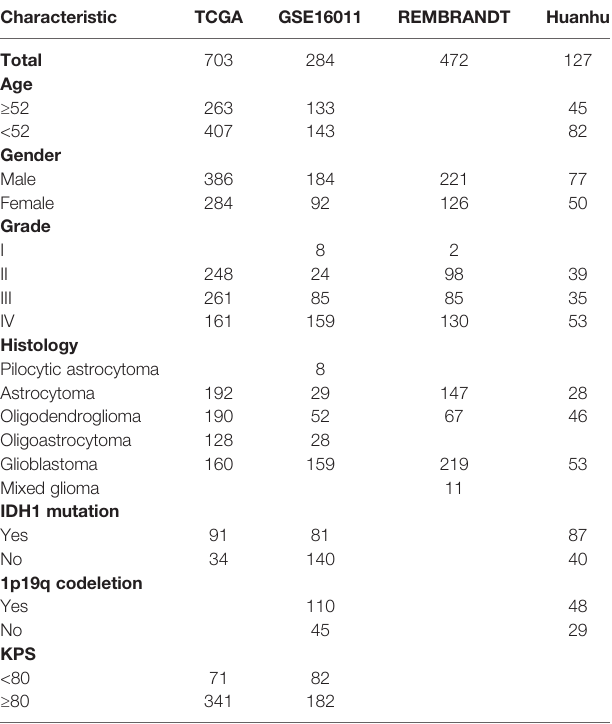
TABLE 1 | The information of patients in 4